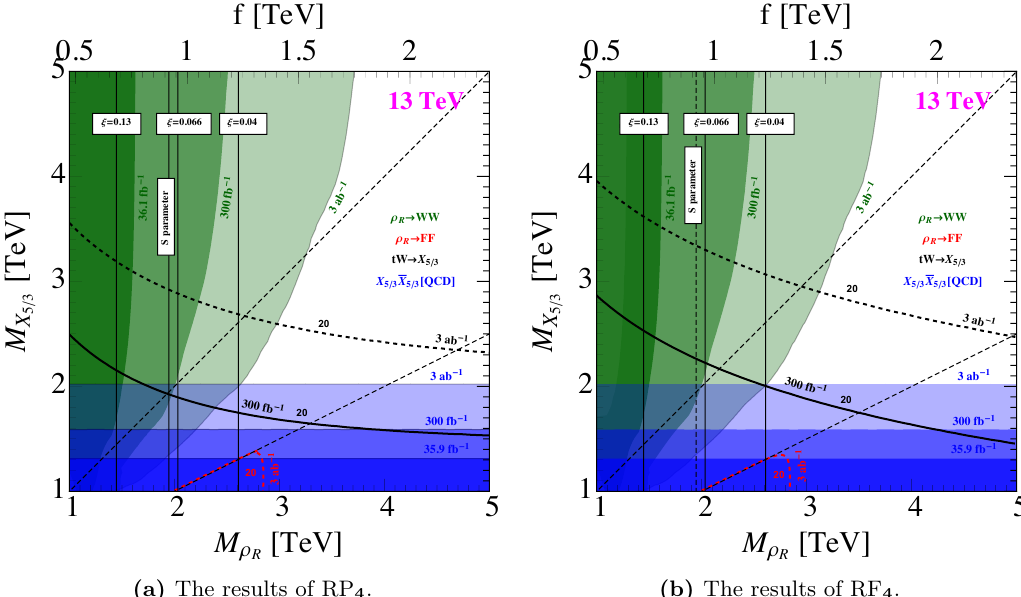
Figure 8. The current limits and prospective reach on model RP 4 (left plot) and model RF 4 (right plot). The parameters are chosen as eq. (3.2). The existing limits from Drell-Yan (cid:26) 0 (cid:22) X and X [QCD] [13] are shown as the darkest shaded regions, while the projections for 300 5 = 3 5 = 3 (3000) fb (cid:0) 1 are shown as lighter shaded regions. The event number contours for N ( ‘ (cid:6) ‘ (cid:6) +jets) = 20 are drawn in solid (dashed) lines for 300 (3000) fb (cid:0) 1 , as a prospective limit for the (cid:26) 0 (denoted as (cid:26) R ! FF ) and the tW ! X 5 = 3